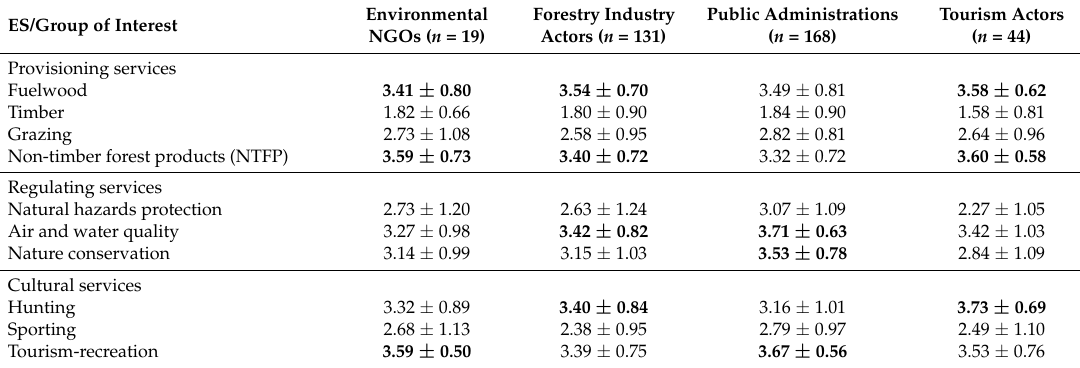
Table 3. Stakeholders’ preferences for ten ES by groups of interest (mean